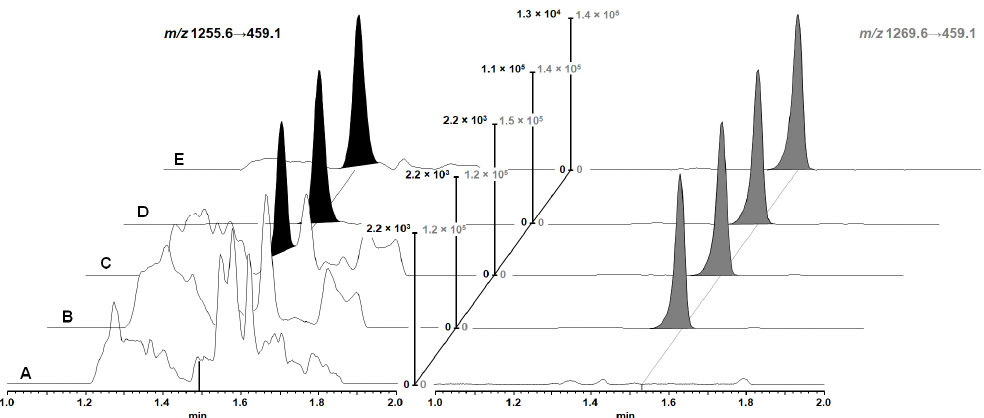
Figure 2. Selected UPLC-MS/MS chromatograms of the processed brain tissue homogenate samples, with the analyte tran- sition in black and internal standard (IS) transition in grey: A) blank sample, B) sample with added IS, C) sample at a lower limit of quantification (LLOQ) level (representing 0.050 ng/mL), D) sample at a mid QC concentration (representing 3.00 ng/mL), and E) brain tissue sample 2 h after intravenous administration of 0.5 mg/kg actinomycin D to mouse #1 (calcu- lated actinomycin D concentration 0.409 ng/mL corresponding to 4.09 ng/g due to tissue homogenization at 0.1 g/mL). The intensity of the blanks was normalized to the value of the analyte peak in the LLOQ chromatogram while the intensity in the remaining chromatograms was normalized to the analyte peak with the IS and analyte transition processed inde- pendently.